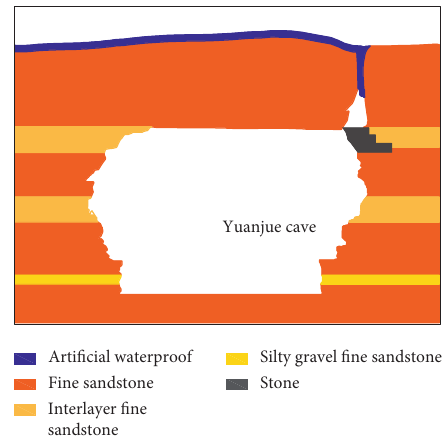
Figure 4: Structure characteristics of B-B section.